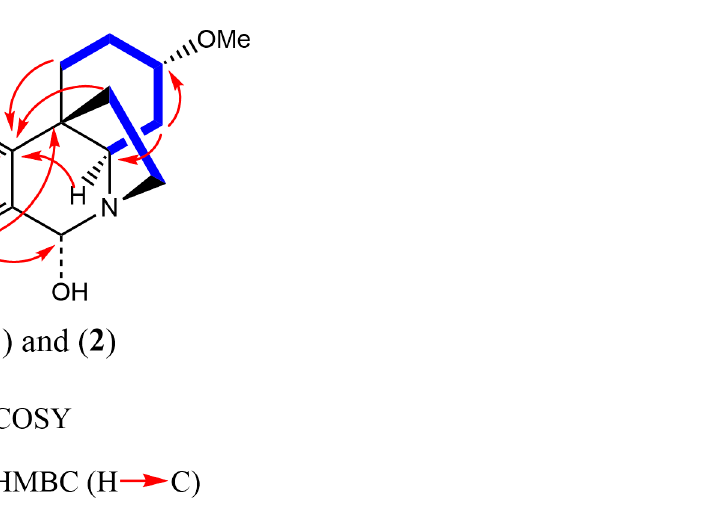
Figure 4. Key HMBC and COSY correlations for two 6-epimers of 6-hydroxyhippeastidine.